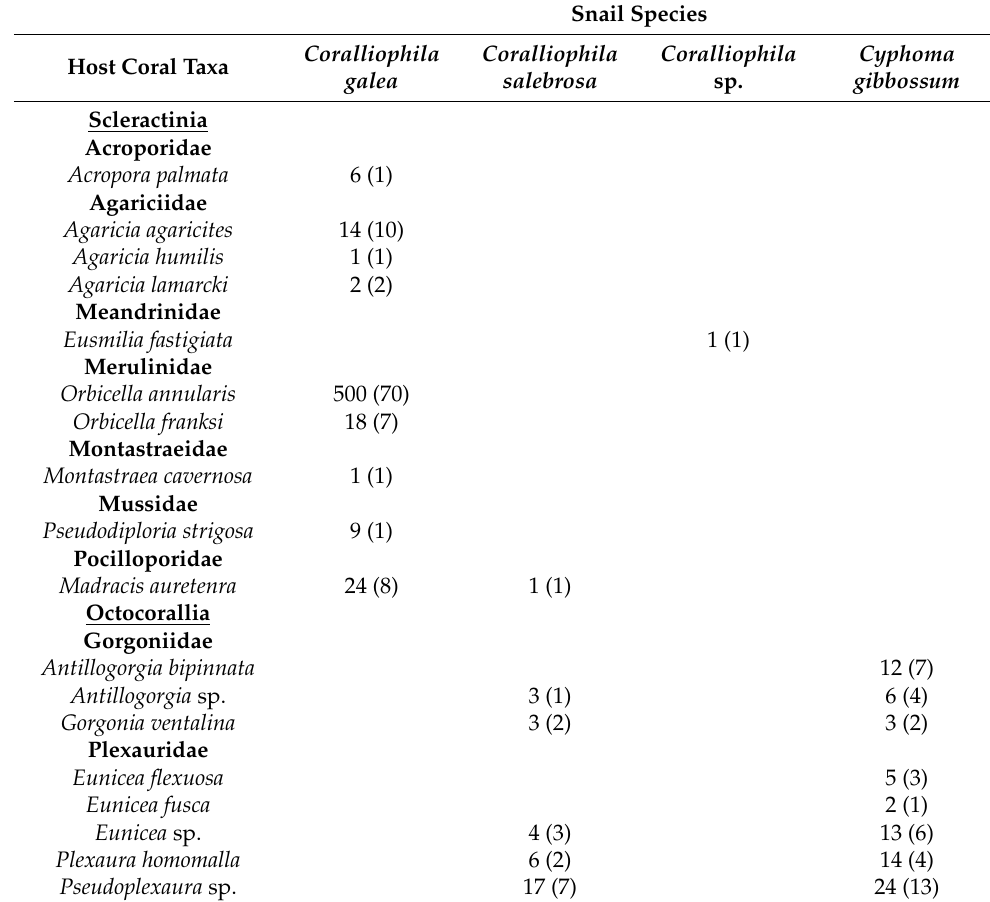
Table 1. Host corals of corallivorous gastropods on Bonaire. The total number of associated snails is shown with the number of host corals in brackets. Coralliophila sp. is an unidentified snail. Snail Species Coralliophila Coralliophila Coralliophila Cyphoma Host Coral Taxa galea salebrosa sp.